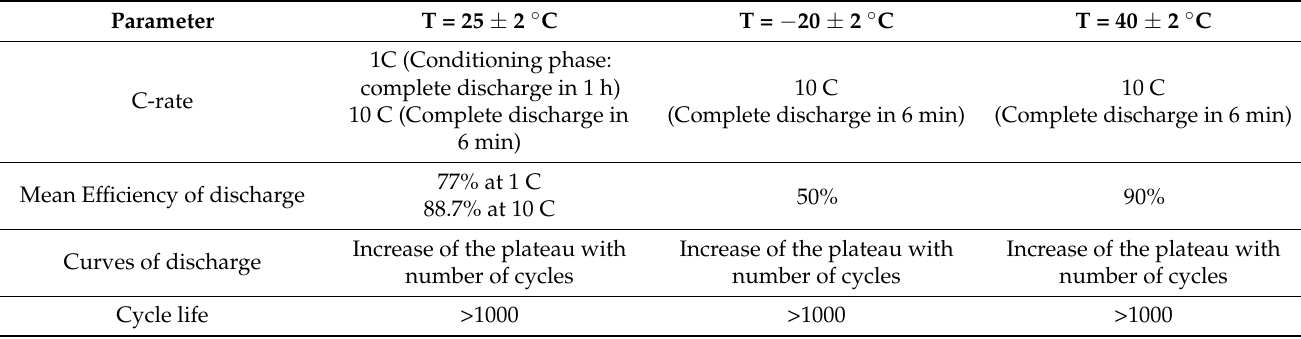
Table 1. Performance of nanostructured cells at different